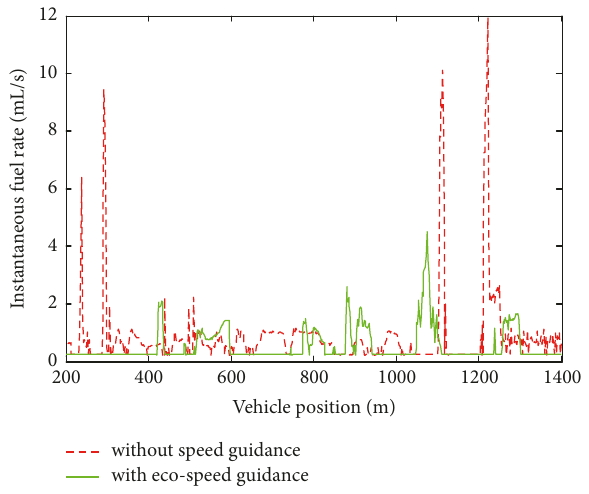
Figure 7: Instantaneous fuel rate comparison for vehicles with and without speed guidance.